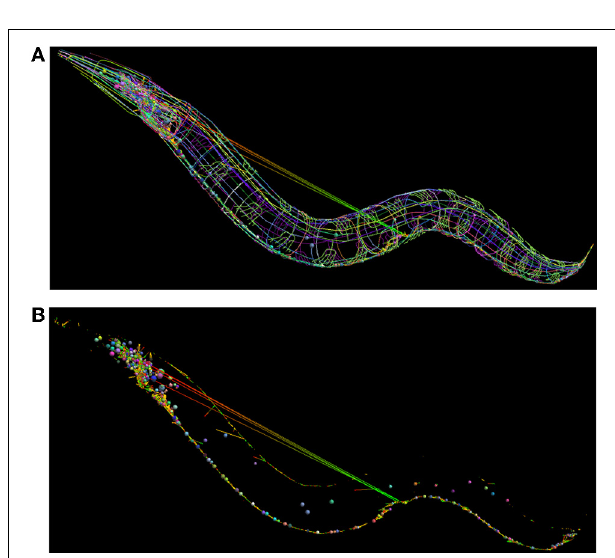
Figure 8 | Use of NeuroML and libNeuroML in the OpenWorm project. (A) The full set of 302 neurons in the OpenWorm model are available in NeuroML format and are visualized here. Each cell, together with its spherical soma, is a different uniform color. Connections between neurons are shown as straight lines varying in color from presynaptic point (green) to postsynaptic point (red). These connections were generated by a Python script using libNeuroML based on connectivity data for pairs of cells. The long straight connections from cells in the midpoint of the worm to the head indicate an error in the connections in the data. (B) Same network as (A) , but only the somas of the cells, along with the synaptic connections are shown. The majority of connections are a short length due to the overlap between the neurites of the presynaptic and postsynaptic cells.